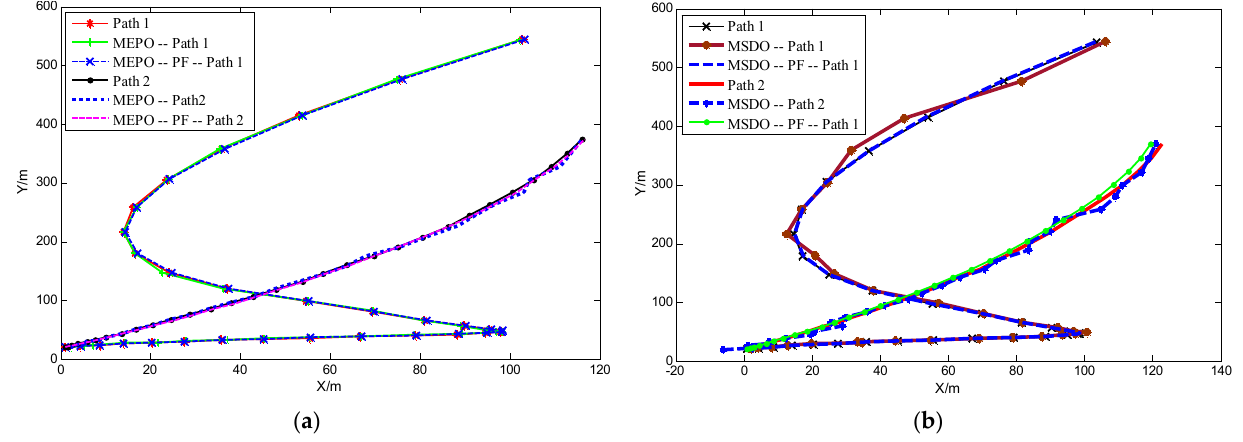
Figure 7. ( a ) The trajectories of MEPO localization method using PF or not ( b ) The trajectories of MSDO localization method using PF or not.